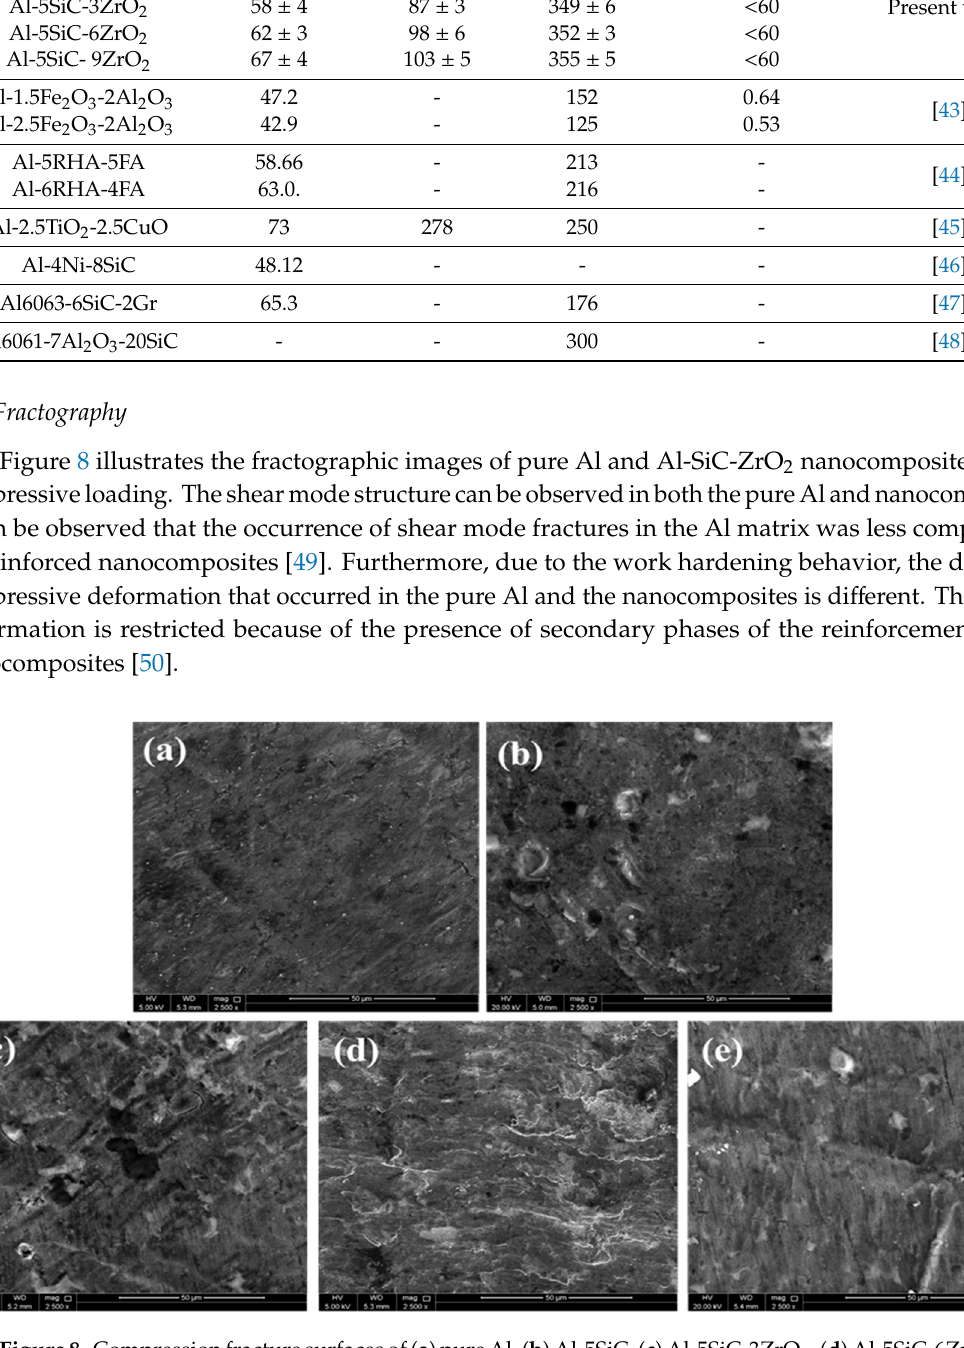
Figure8. Compressionfracturesurfacesof( a )pureAl, ( b )Al-5SiC,( c )Al-5SiC-3ZrO 2 , ( d )Al-5SiC-6ZrO 2 , Figure 8. Compression fracture surfaces of ( a ) pure Al, ( b ) Al-5SiC, ( c ) Al-5SiC-3ZrO 2 , ( d ) Al-5SiC- and ( e ) Al-5SiC-9ZrO 2 6ZrO 2 , and ( e ) Al-5SiC-9ZrO 2 nanocomposites.